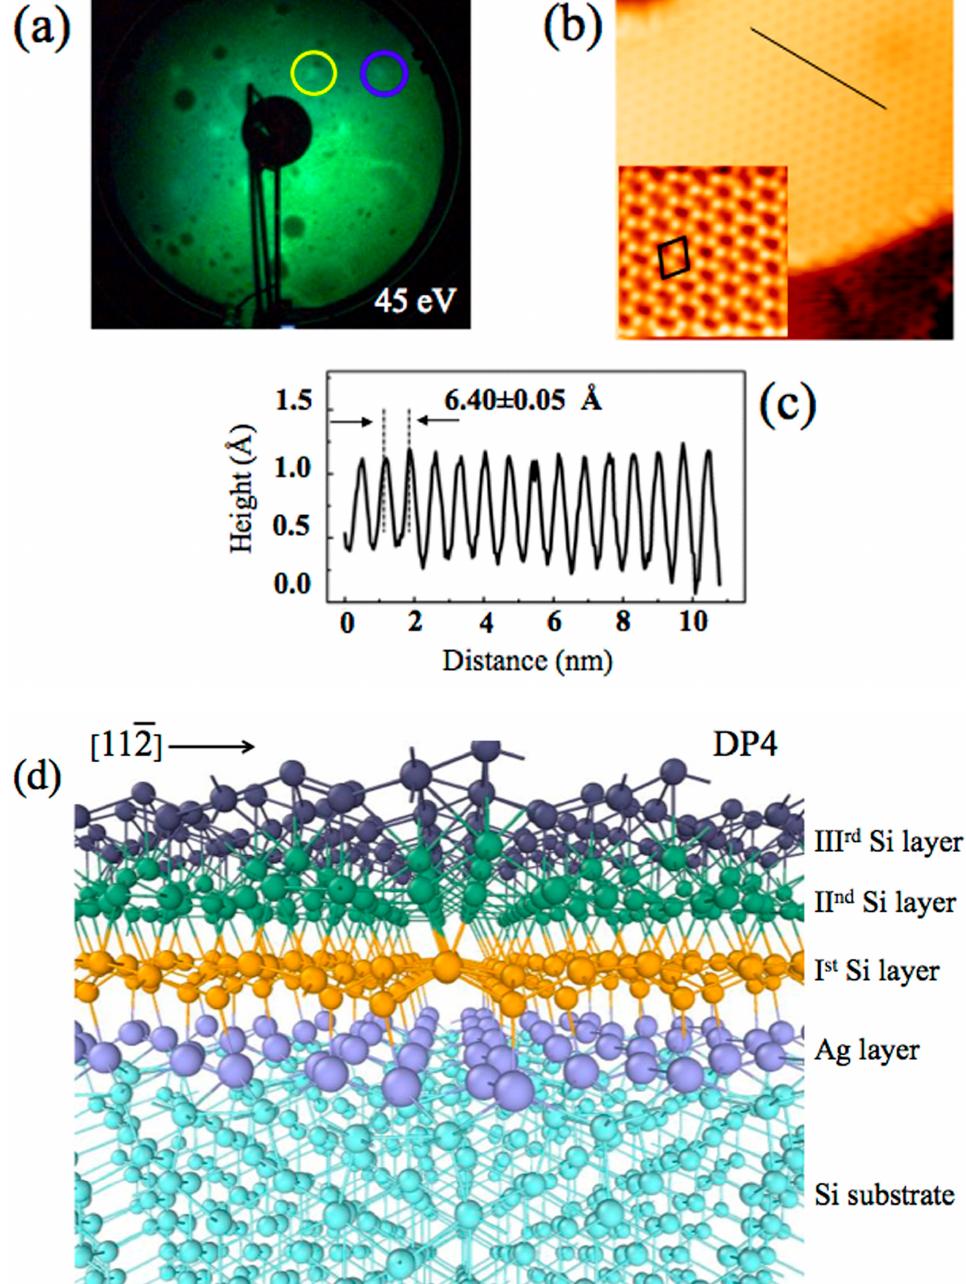
Figure 1. LEED patterns for ~10 MLs of silicon deposited onto the Si(111) √ 3–Ag surface at ~ 200 °C, yellow circle: (1/3,1/3) order spot of the Ag √ 3 × √ 3 reconstruction; blue circle: silicon integer order spot ( a ). Empty- and filled-state STM constant-current images, measured at 77 K from ~5 MLs of silicon deposited onto Si(111) √ 3–Ag surface at ~ 200 °C: ( b ) 15 × 15 nm 2 (50 pA and -1.0 V) and its inset 5 × 5 nm 2 , (50 pA and 0.4 V) at atomic resolution; √ 3 × √ 3-Si unit cell is drawn. (c) is the line profile of the black line of (b). ( d ) is the side view three-dimensional (3D) representation of the DP4 model. Adapted with permission from (J. Phys. Chem. C, 2017 , 121, 27182–27190). Copyright (2017) American Chemical Society. Empty- and filled-state STM at 15 × 15 nm 2 (50 pA and − 1.0 V) and 5 × 5 nm 2 (50 pA and 0.4 V) √ √ atomic resolution images show the 3 × 3 multilayer silicene (unit cell is drawn) and (c), which is the √ √ line profile of the black line traced in (b) that clearly quantifies the side of the 3 × 3 reconstruction